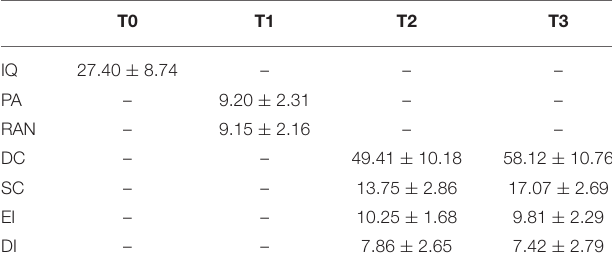
TABLE 2 | Descriptive statistics for all variables at all time points (M ± SD).